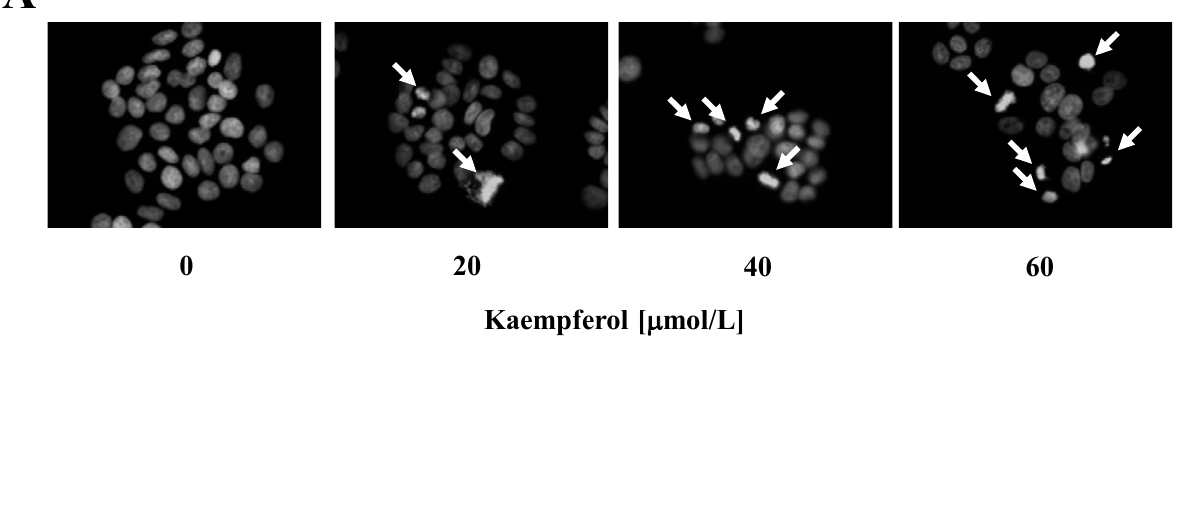
(0 μmol/L kaempferol) were set at 100%. The adjusted mean ± SEM ( n = 3) of each band is shown above each blot. Means without the same letter (a, b, c or d) are significantly different ( p <